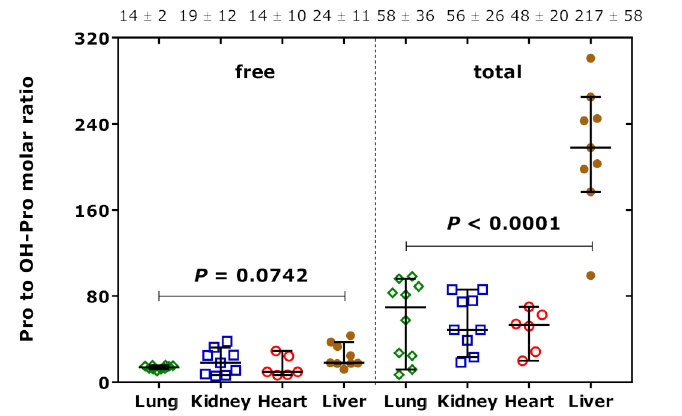
Figure 7. Molar ratio of Pro to OH-Pro in their free and proteinic forms in organ homogenates of the rats. Data are shown as the median with 95% confidence interval ( n = 6–10). One-way ANOVA was performed in both cases. The numbers on the top of the Figure are the mean ± standard deviation values of the respective molar ratios.